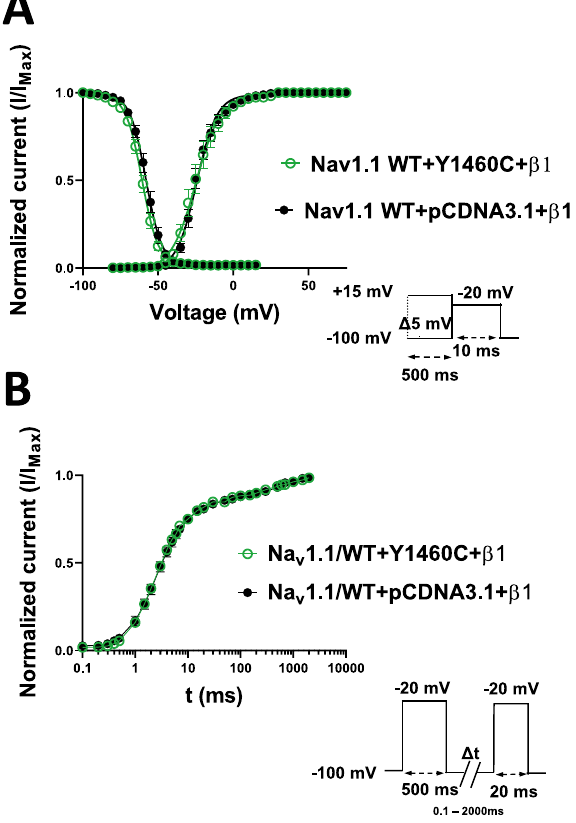
Figure 3. Gating properties of steady-state activation and inactivation and recovery from slow inactivation. ( A ) Voltage-dependence of steady-state activation (left) and inactivation (right) in WT with pCDNA3.1 (activation, n = 11, and inactivation, n = 11) and WT with Y1460C (activation, n = 11, and inactivation, n = 15). The inactivated currents were generated using the protocol described in the insets. and the activated currents were obtained from the I/V recordings. The resulting data were fitted to a standard Boltzmann function. ( B ) Time courses of recovery from slow inactivation in WT with pCDNA3.1 (n = 14) and WT with Y1460C (n = 14).